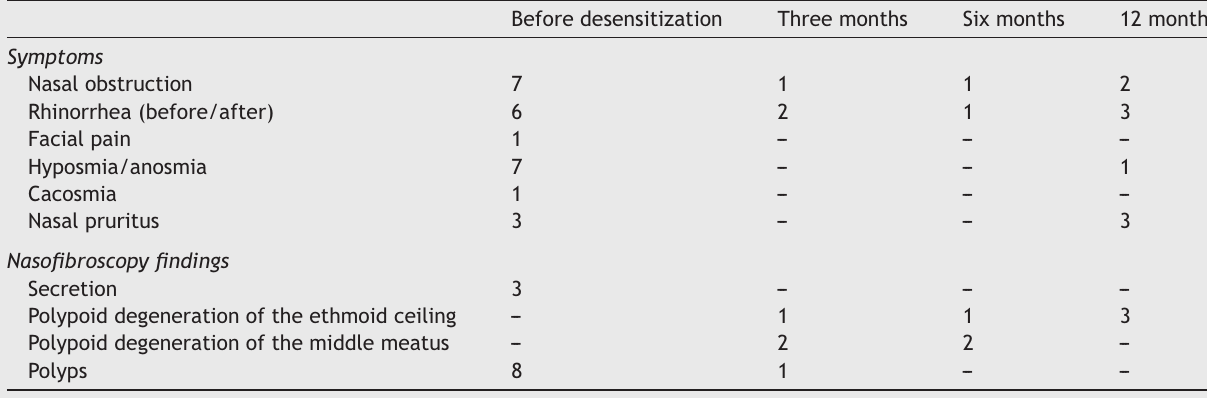
Symptoms and nasofibroscopy findings in eight patients undergoing aspirin desensitization during follow-up. Before